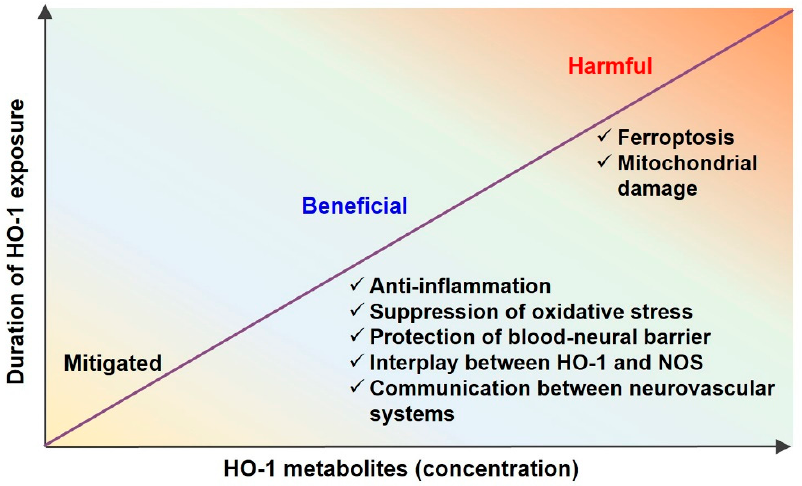
Figure 2. Effects of heme oxygenase (HO) metabolites according to concentration and duration of exposure. At low concentrations and short exposure durations, HO metabolites may be non-functional. At moderate concentrations and moderate exposure durations, HO metabolites may be beneficial, exhibiting anti-inflammatory effects, reduced oxidative stress, blood–neural barrier protection, stimulation of the interplay between HO-1 and nitric oxide synthase (NOS), and consequent communication between neurovascular systems. However, at high concentrations and long exposure durations, HO metabolites may be harmful by inducing ferroptosis and mitochondrial damage.